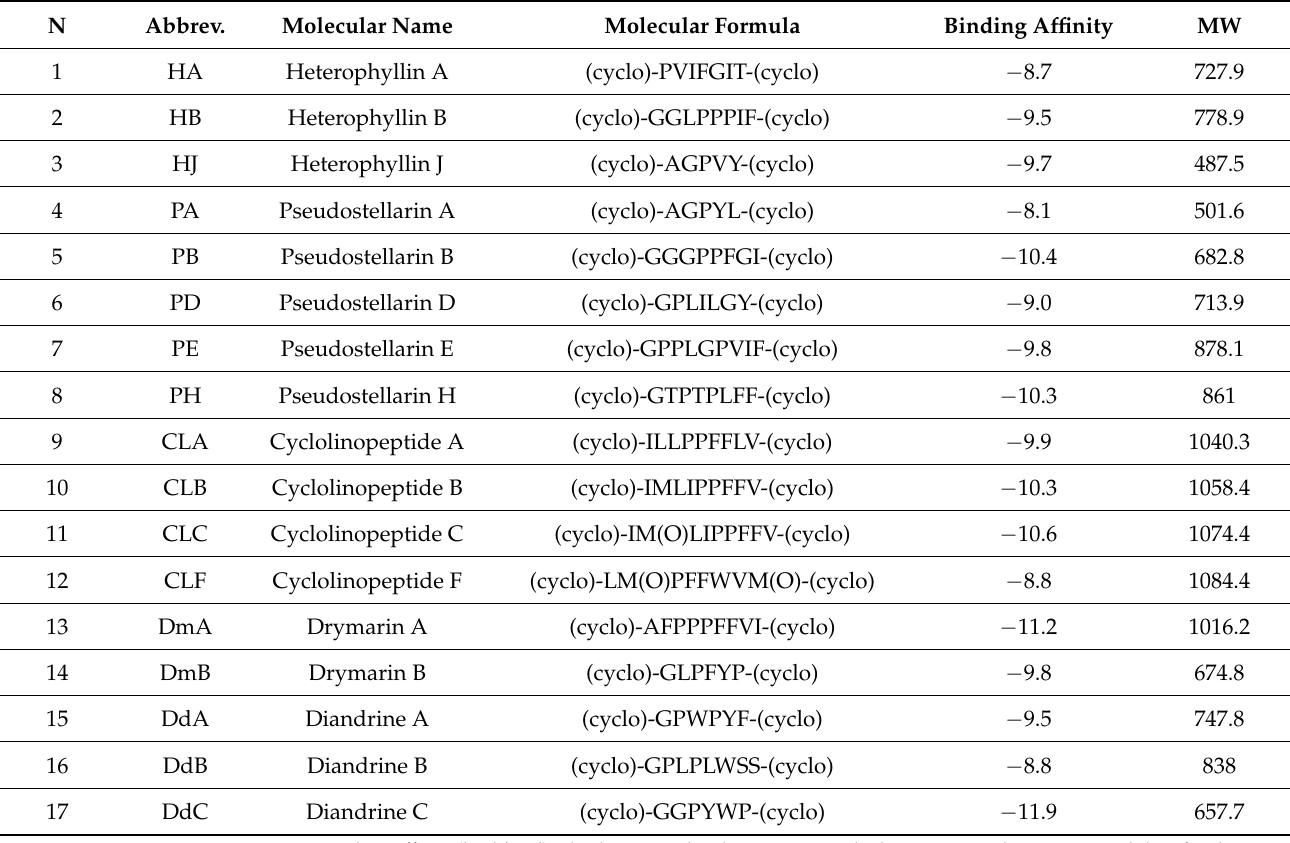
Table 1. The docking result of a series of plant cyclopeptides with